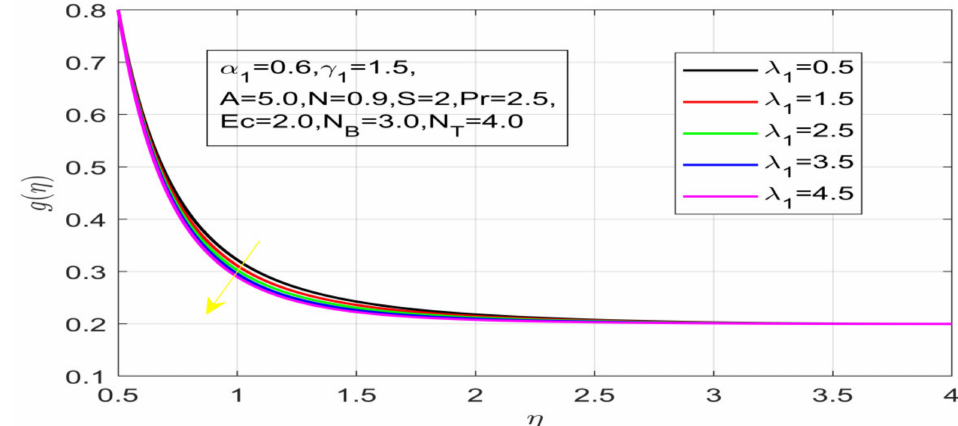
Figure 10. Impact of λ _1 on azimuthal